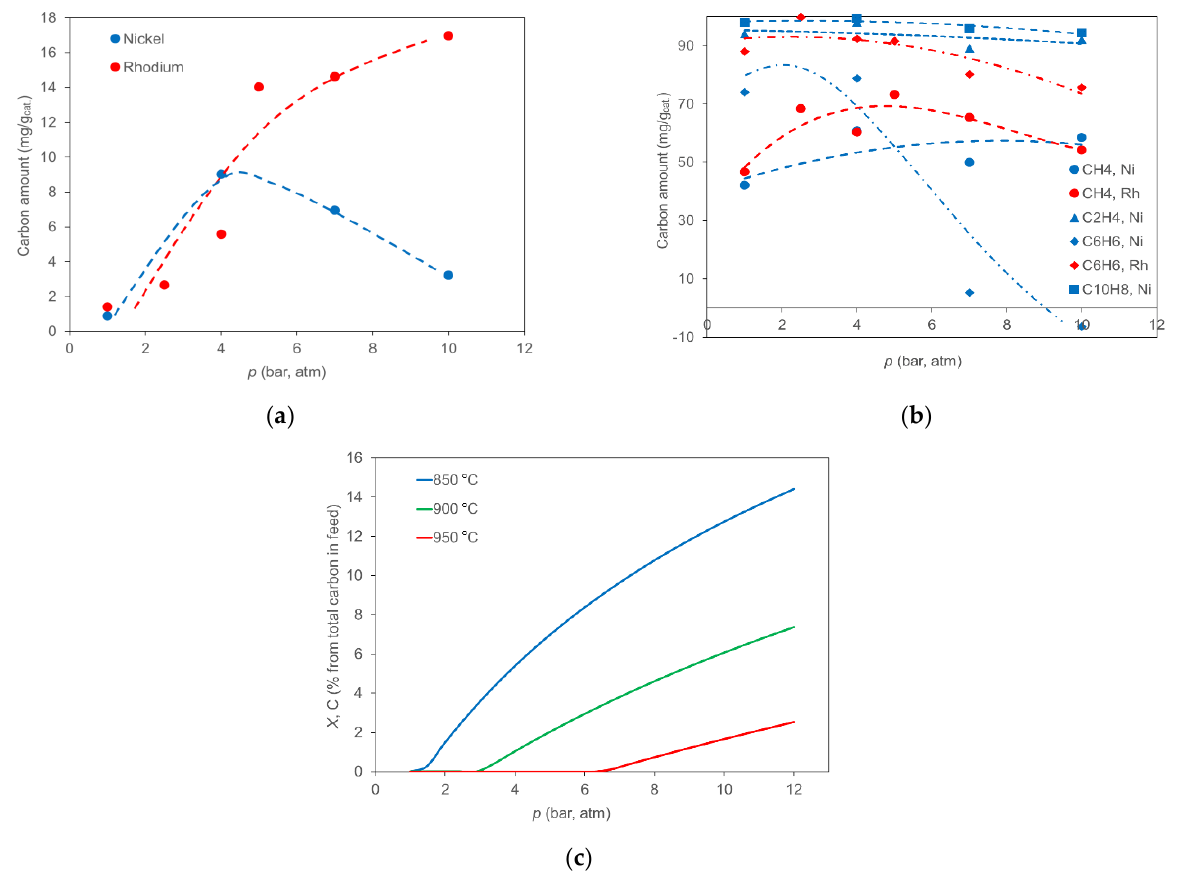
Figure 8. Effect of pressure on ( a ) carbon formation and ( b ) CH 4 , C 2 H 4 , C 6 H 6 and C 10 H 8 conversions for Ni- and Rh-catalysts (test runs 5, 10, 15 – 22). Reaction conditions: pressure 1 – 10 bara, 20,000 vol-ppm ethylene, 900 °C, TOS 5 h and gas composition 1. ( c ) Carbon formation according to thermodynamic calculation by HSC Chemistry.